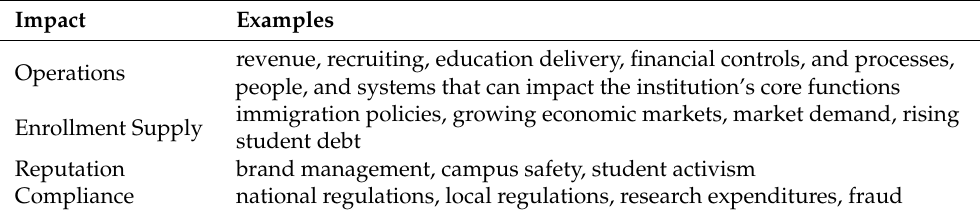
Table 3. Types of Institutional impacts and